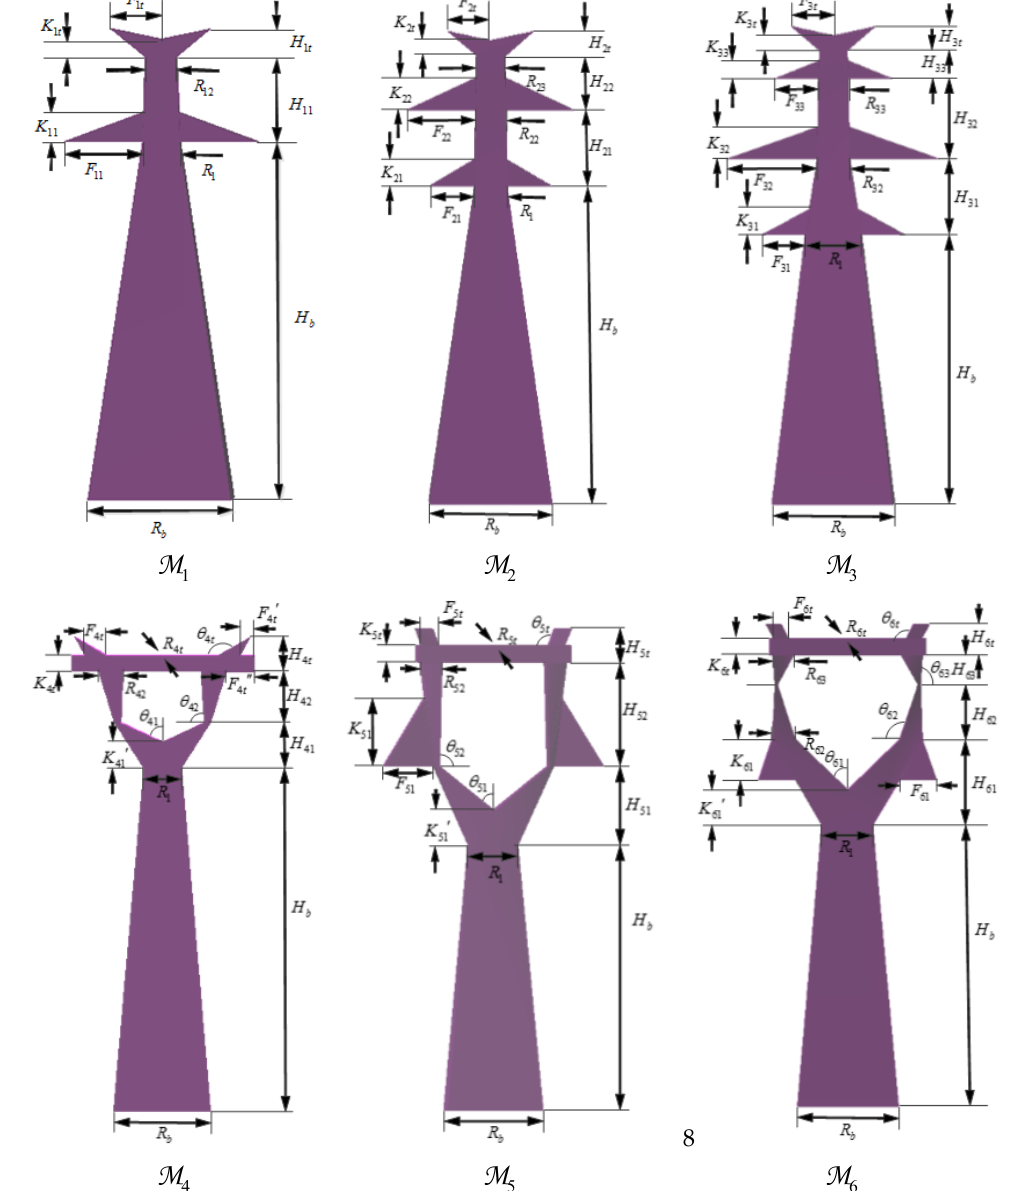
Figure 1. 3D object library M . There are six models in the library. The pylon models are represented using polyhedrons. The pylon parameters are specified as the height, width of arms, the positions of turning points, and other specific parameters.